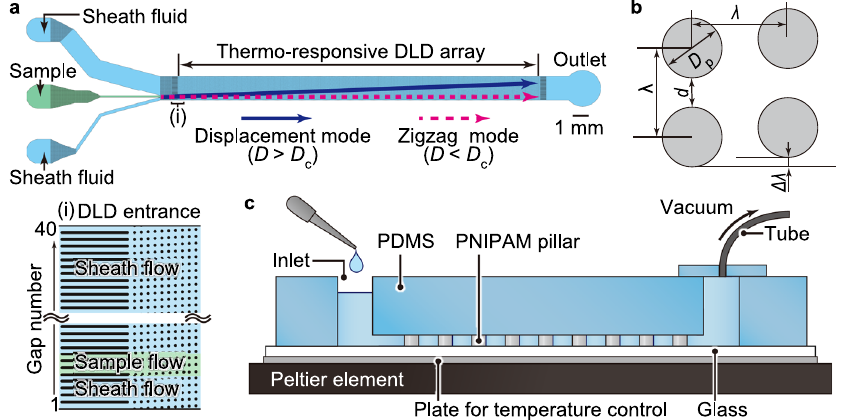
Figure 2. A thermally-tunable microfluidic DLD device. ( a ) Schematic illustration of the thermo-responsive DLD device. The inset illustrates the entrance of the DLD array, and each gap between the pillars is numbered from 1 to 40. ( b ) A rhombic unit cell with the array parameters. D p = 20 μm, λ = 50 μm, Δ λ / λ = 0.05, and d = λ – D